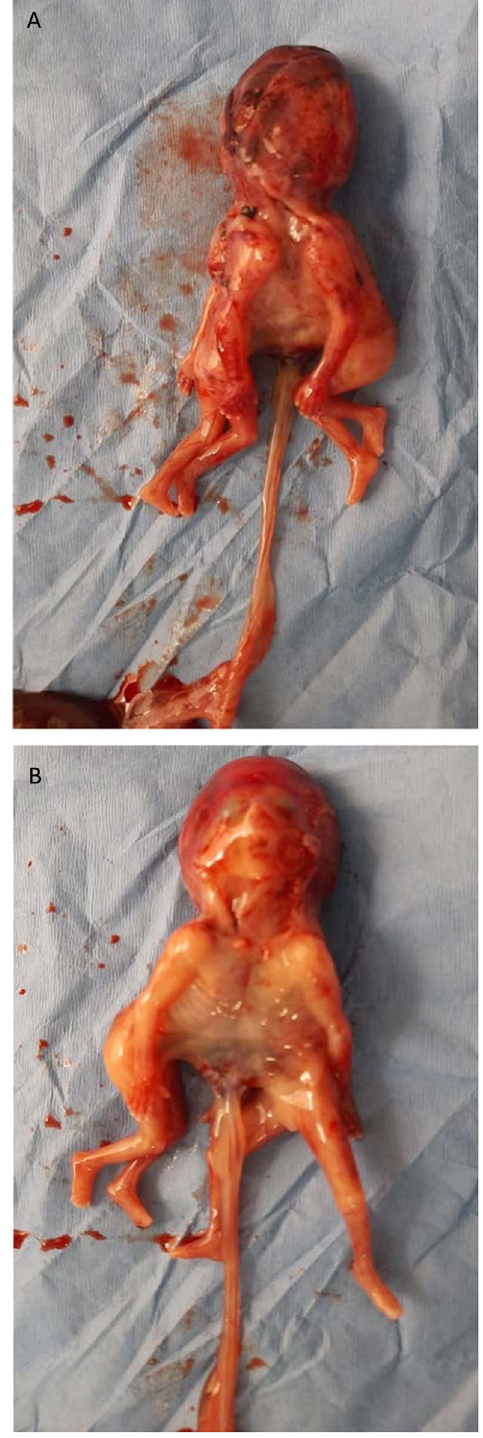
Fig. 3 A single head and face were seen with two eyes, two ears, single nose, and mouth. No cleft-palate/-lip was seen ( A–B ). No obvious other facial structures/skin tags were identified on the other side of the